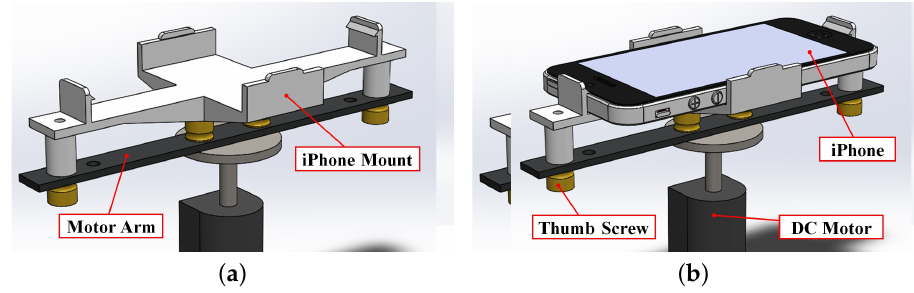
Figure 2. Design of a mount for the DC motor ( a ) without and ( b ) with a smartphone